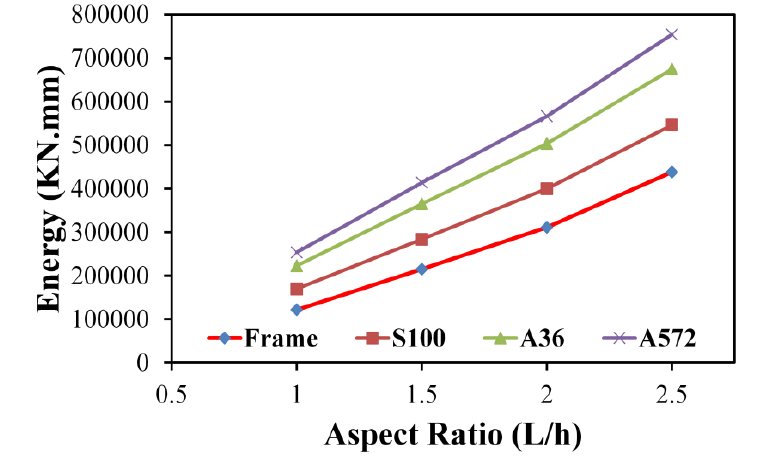
Fig. 14. The energy absorbed by the finite element models. Energy absorption of the finite element